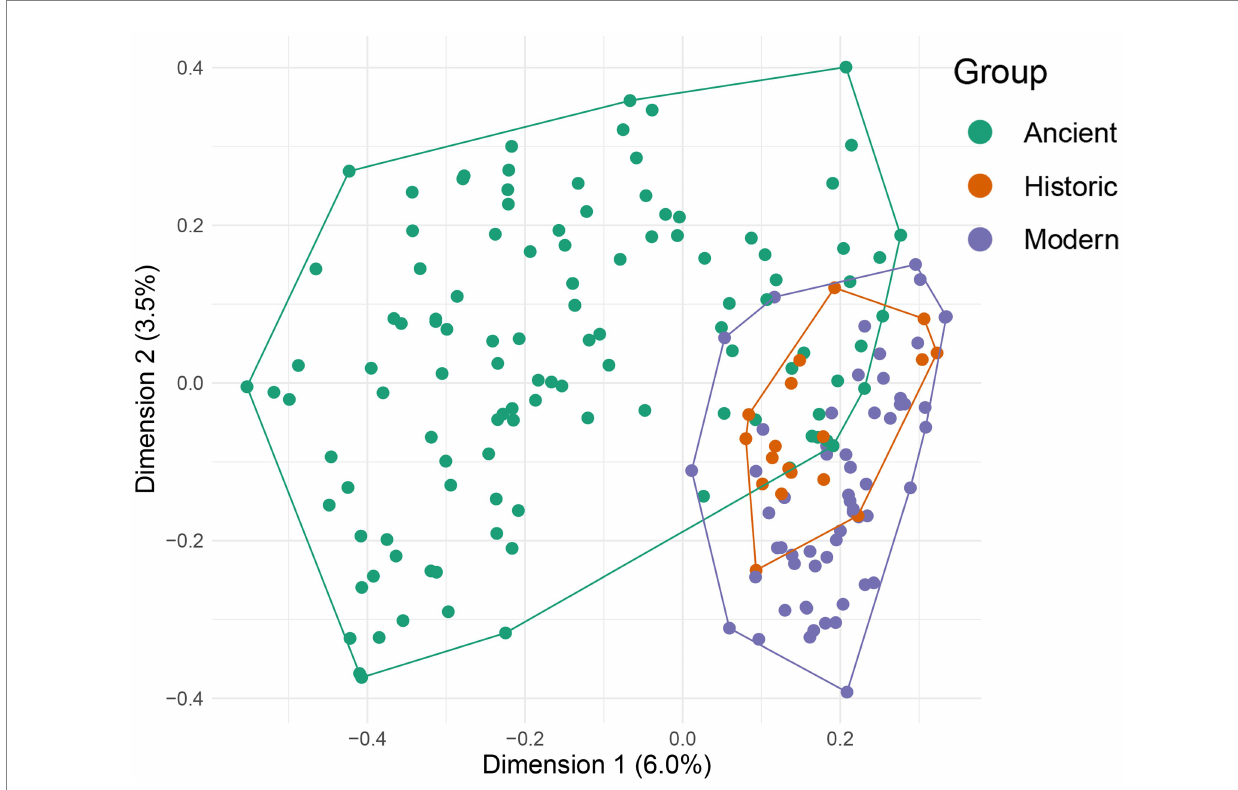
FIGURE 6 Classical MDA (PcOA) ordination of all observations for all genes (excluding palynomorph data, presence absence only) based on Bray-Curtis